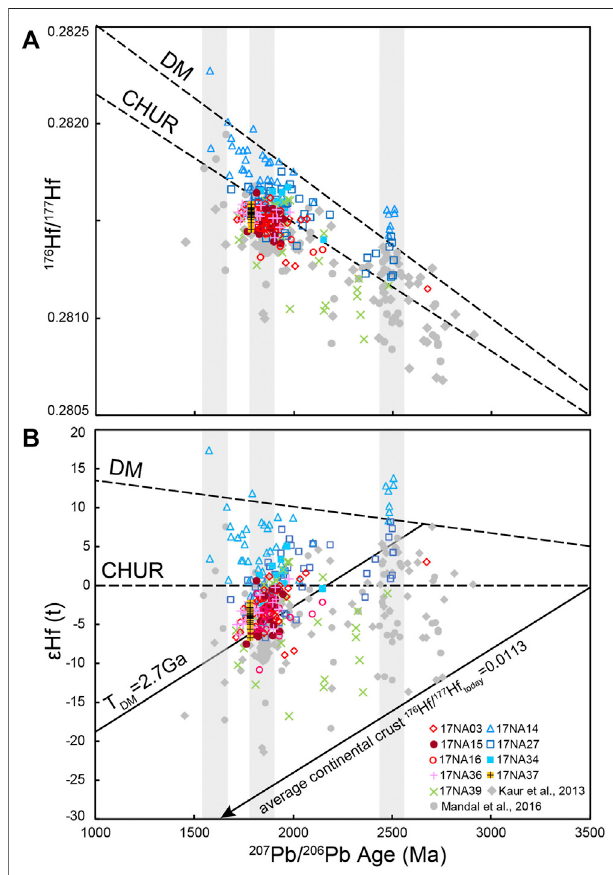
FIGURE8|(A) Plotof 176 Hf/ 177 Hfvs. 207 Pb/ 206 Pbagesofzirconsforthe orthogneiss and metasedimentary rocks in the Arun Valley. (B) Plot of Ɛ Hf (t) vs. 207 Pb/ 206 Pb ages of zircons. Reference data of Mandal et al. (2016) are fromtheAskotklippe,KumaunofNorthwestIndia,anddataofKauretal. (2013) are from the Aravalli Supergroup of West India.